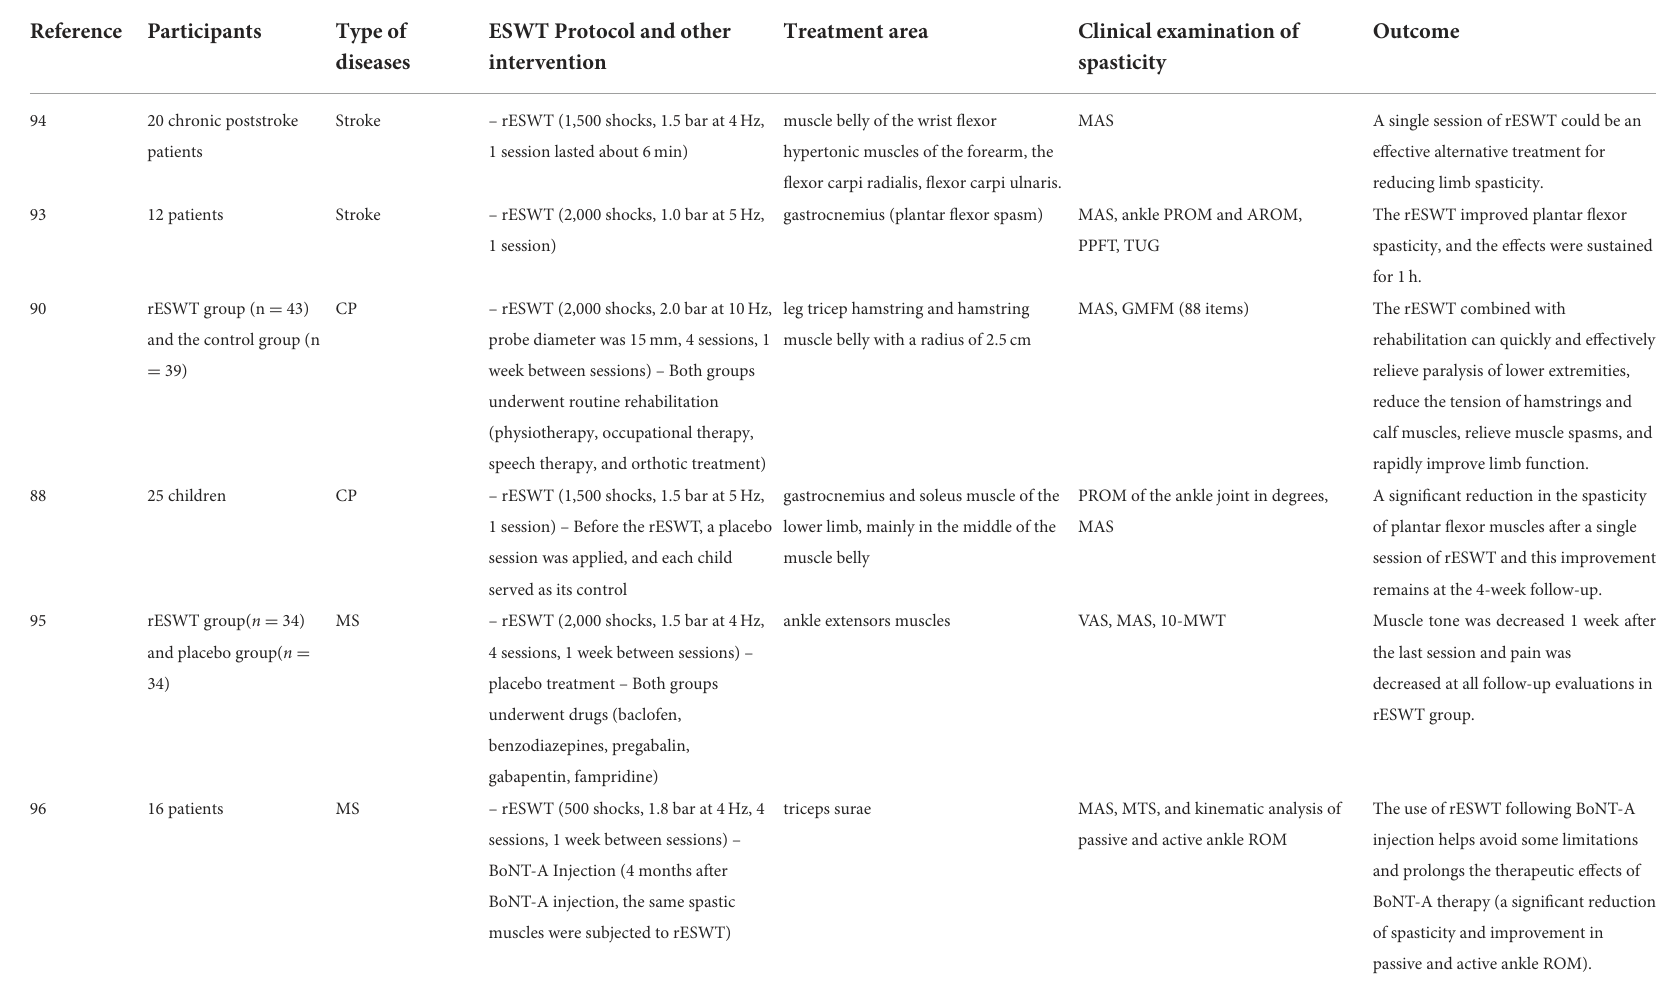
TABLE 2 The application of rESWT to treat spasticity in people with central nervous system